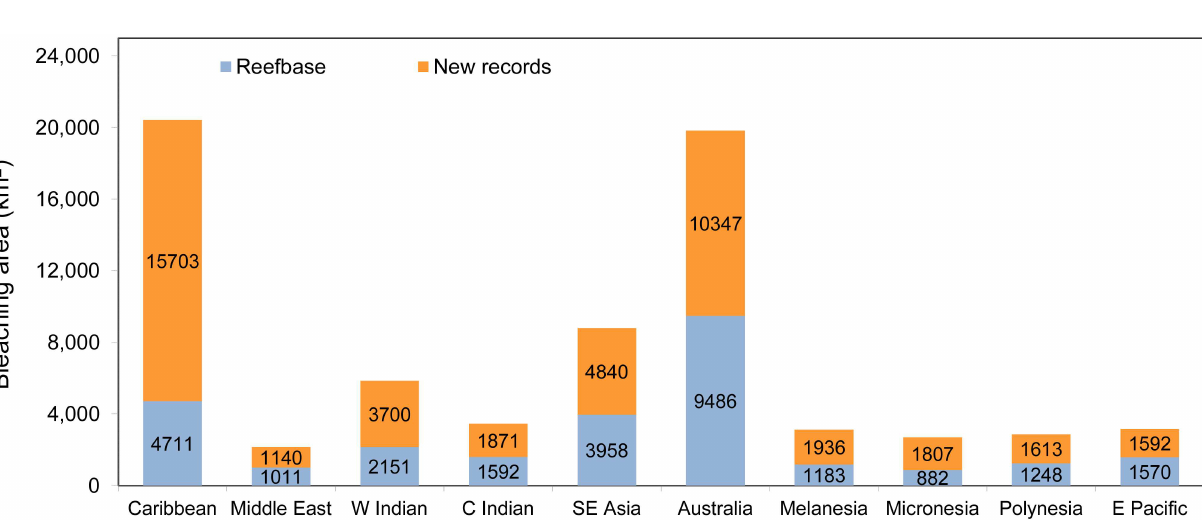
Fig 3. Total area (km 2 ) of moderate and severe(level 2 and 3) bleaching by region over the 1985–2010period. The area is computed based on 0.04˚ × 0.04˚ latitude-longitude grid cells representingoriginalReefBasereports (blue) and new reports (orange).